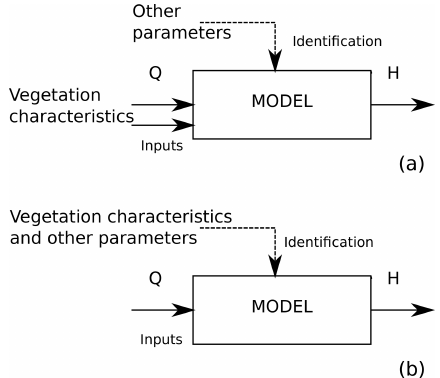
Figure 1. Two ways to define the parameter identification problem for process-based methods of channel discharge: (a) traditional ap- proach; (b) adapted in the present